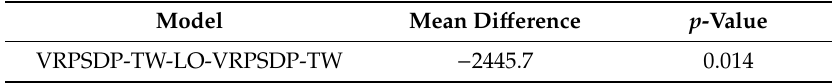
Figure 2. Difference of performance between vehicle routing problem with simultaneous delivery and pick-up under a time window, VRPSDP-TW, and considering left over cost, VRPSDP-TW-LO. Table 3. Result of paired t